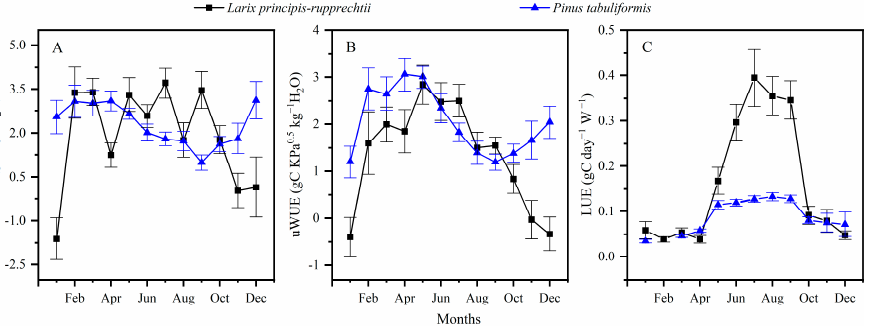
Figure 7. Monthly variations of the water use efficiency (WUE) ( A ), underlying water use efficiency (uWUE) ( B ), and light use efficiency (LUE) ( C ) in two forest ecosystems. The value for each point in each panel represents the mean value and standard error for each month.